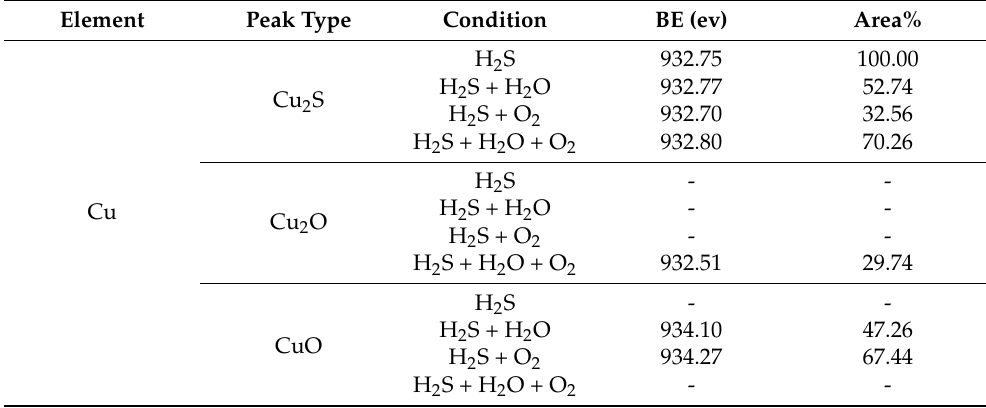
Table 4. The content ratio of each phase in the corrosion products in the Cu 2p spectrum. Element Peak